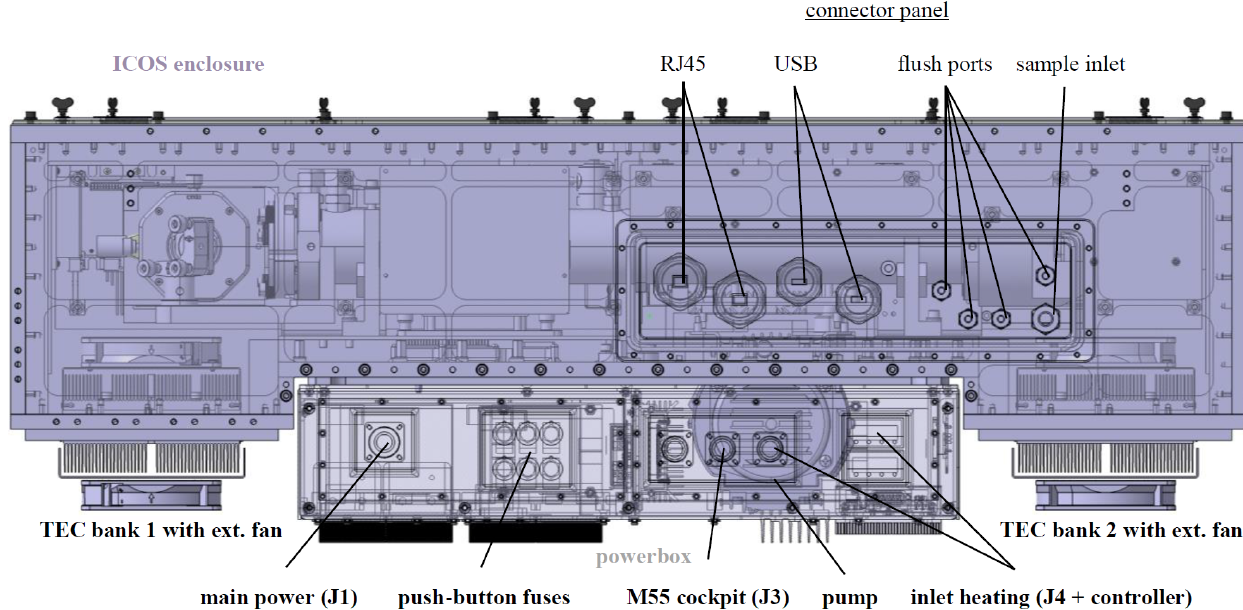
Figure 1. Technical drawing of AMICA showing bulk parts. Additional drawings including M55 mounts and the HALO rack are given in Figs. S1 and S2 in the Supplement respectively.